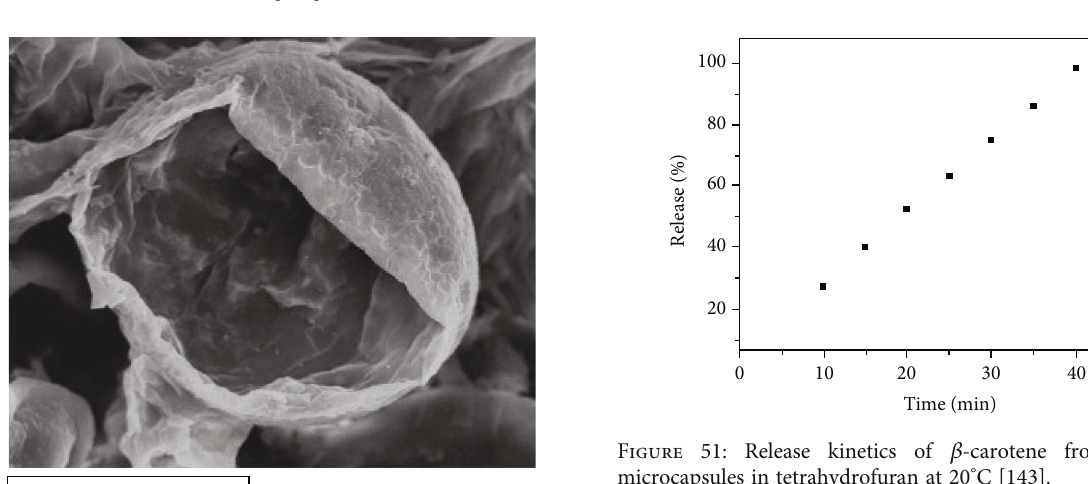
Figure 48: Release of coumarin 1 dye under di ff erent solvent conditions for polyamide capsules prepared with (a) 3 :1 triazine 2:DETA and (b) 1 :1 triazine 2: DETA. (c) Control experiments: 1 :1 triazine 2: DETA with terephthaloyl chloride. Uncertainty represents standard deviation of three measurements [142].